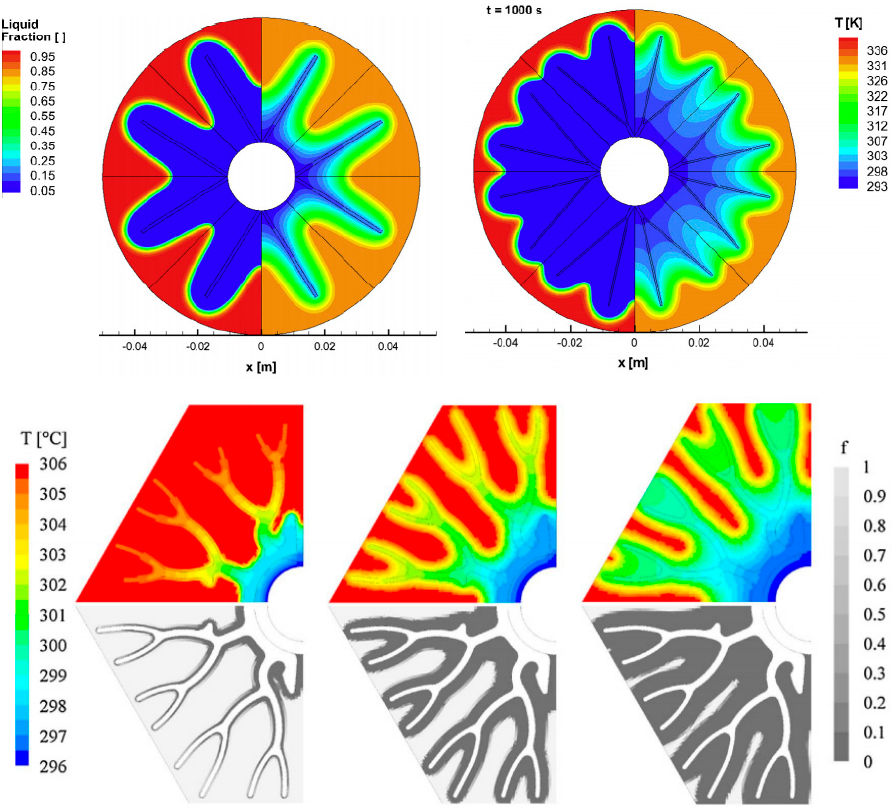
Figure 4. Extended surface fin designs of single ( left ) and double ( right ) bifurcations ( above ) and extended finned tube heating gradient at 100, 500 and 900 s ( below ). The temperature gradients and the liquid fraction of the phase-change material can be seen in the scales. Adapted with permission [109,111]. 2015, 2017 Elsevier.